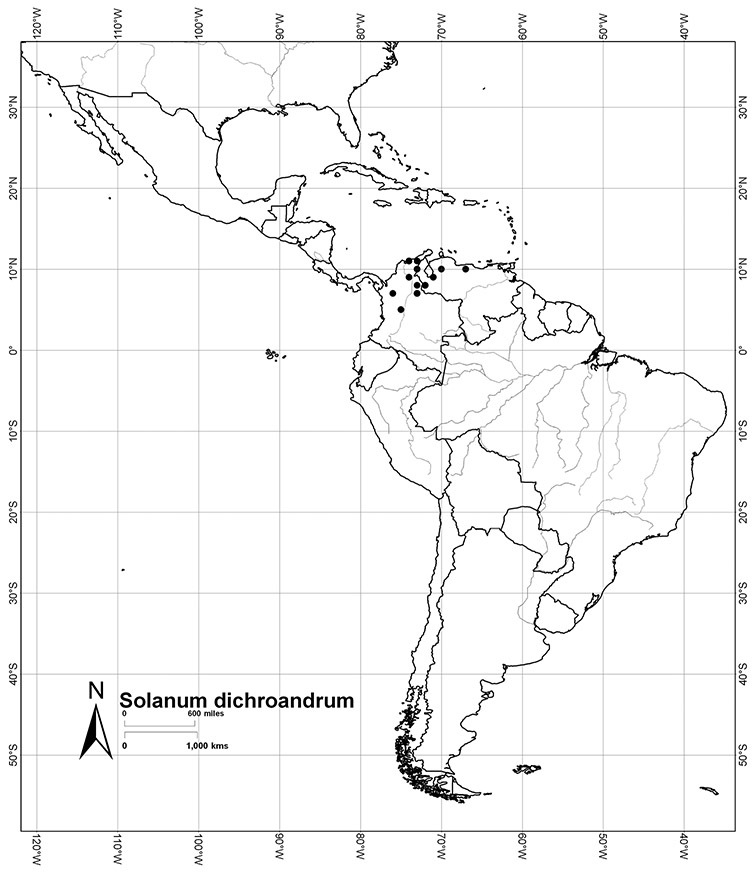
Distribution of Solanumdichroandrum Dunal.